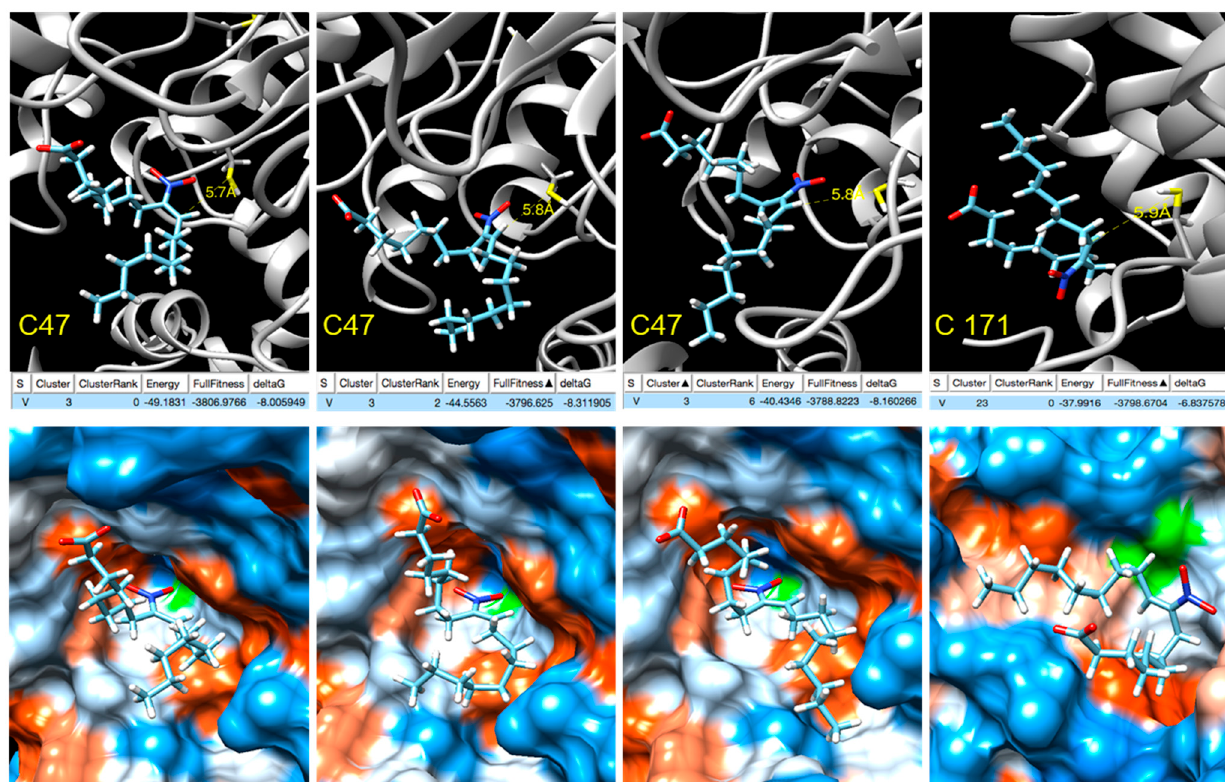
Figure 7. NO 2 -OA docking with Tsa1 Cys 47/Cys 171 (truncated). Active site. Top: Docking poses where the β -carbon next to the nitro group is within 6 Å from the sulfur atoms of the peroxidatic Cys 47 and resolving Cys 171 showing the energy, fullfitness scoring and computed Δ G values. Bottom: Hydrophobic surface colored by the amino acid hydrophobicity on the Kyte–Doolittle scale, from dodger blue for the most hydrophilic to white to orange red for the most hydrophobic .